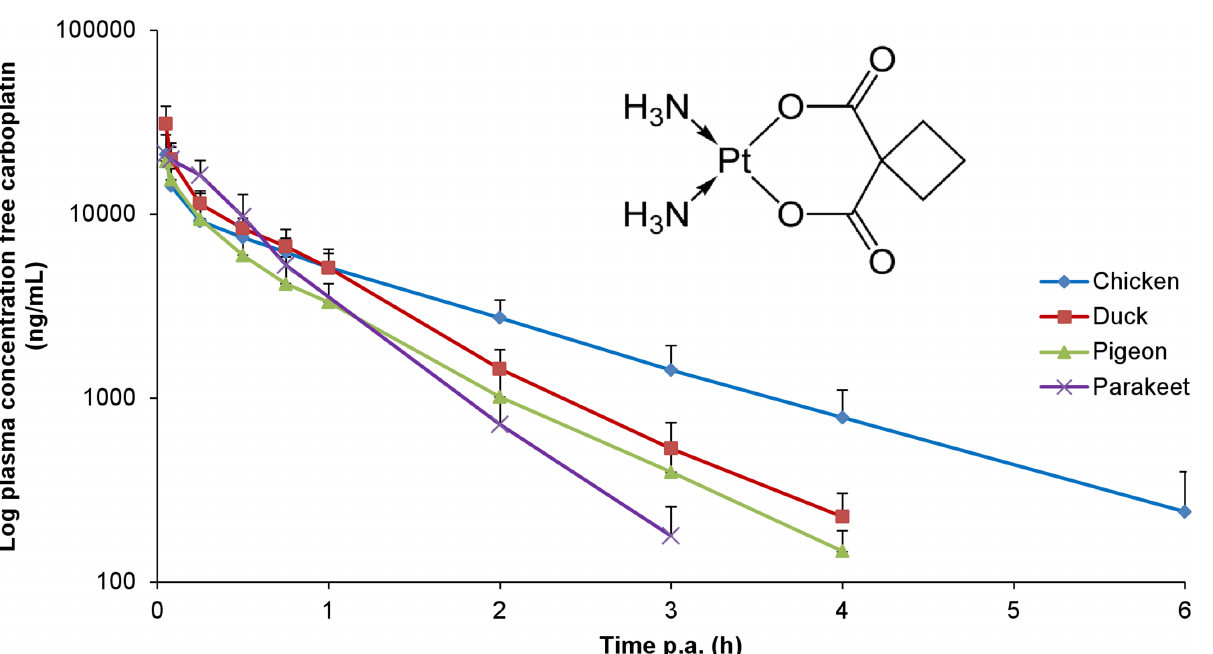
Fig 1. Plasma concentration-time profiles of free carboplatin in different avian species (chicken, duck, pigeon and parakeet) after intravenous administration of 5 mg carboplatin/kg body weight. Values are presented as mean + SD. The insert displays the chemical structure of carboplatin.